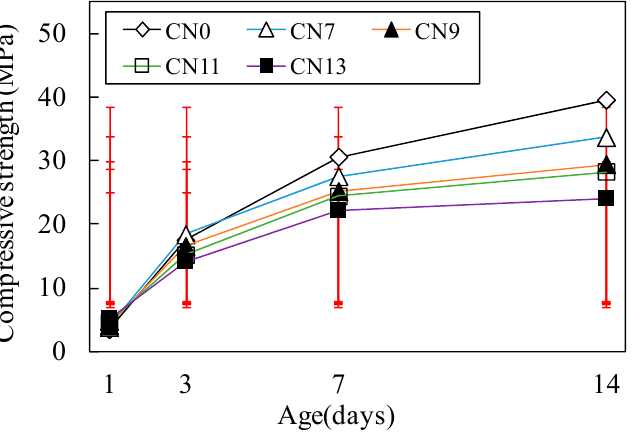
Figure 6. Compressive strength at all ages.